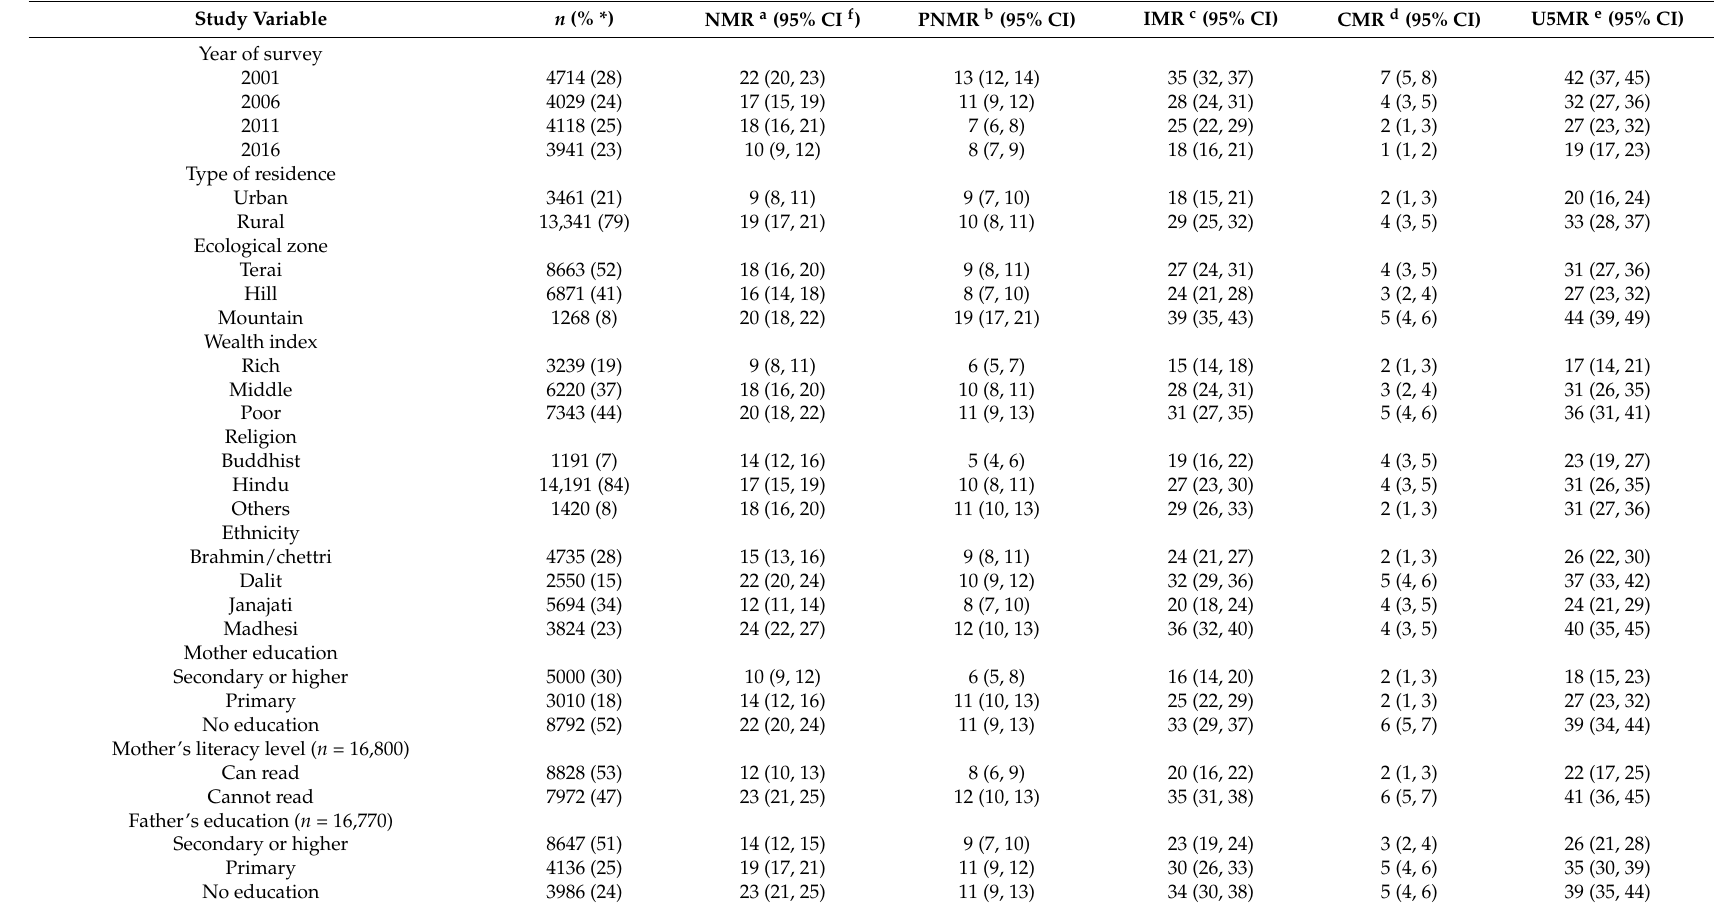
Table 1. Characteristics of the population in Nepal for the 2001–2016 waves ( n =